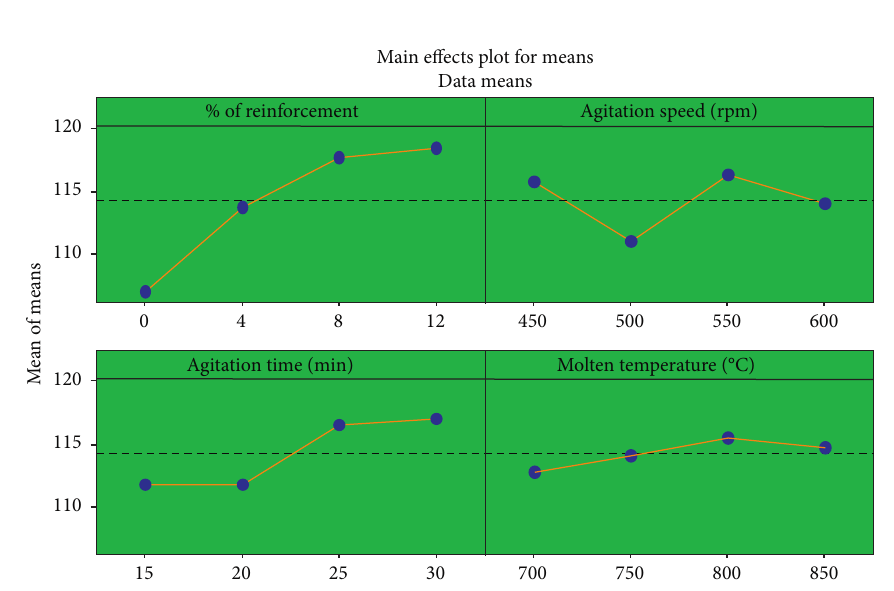
Figure 11: Main effects plot for means (Vickers hardness